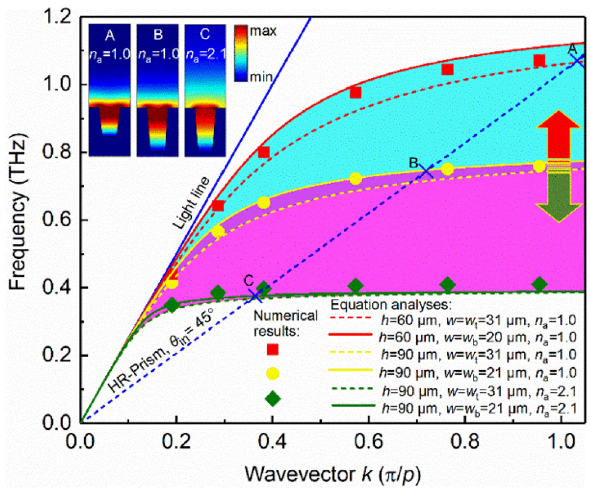
Figure 2: The dispersion relation of the SSPPs supported by corrugated metallic surfaces with different groove depths and refractiveindexfilledinthegroovesintheBrilliounzone.Thecurves are the calculation resultsof SPSsdecorated with 1Darray of square grooves through analytical model. The scatter data (rectangle, roundness, and diamond)are acquired according to the actual sizes of the fabricated SPSs by COMSOL. The dots A, B, and C are numerical results for the case of the momentum matching condition isfulfilled, k SSPPs = k ǁ .Theinsetsshowtheelectric fi elddistributions fortheunitcellofthegrooveswithdifferentgroovedepthsand fi lled refractive